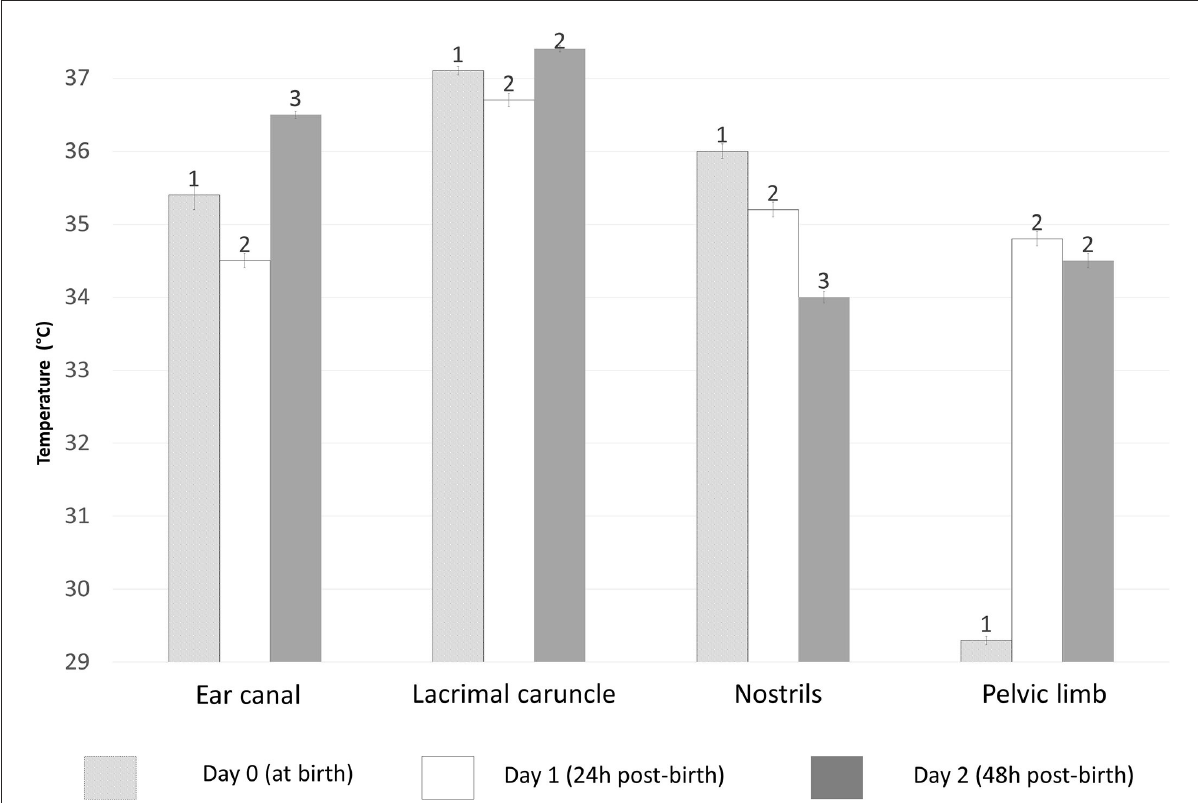
FIGURE6 Effect of age measured in hours (0–48h) on the temperature of newborn buffaloes in different thermal windows. In all events (hours), statistically significant differences ( p < 0.0001) were observed in all measured times, except on the lacrimal gland and pelvic limb windows at 24 and 48h post-birth. The average temperature at the ear canal differed from day 0 to day 2, with the highest value at 48h post-birth (36.5 ◦ C) and the lowest at 24h post-birth (34.5 ◦ C). The lacrimal gland window only showed differences of an average of 0.4 ◦ C from day 0 to day 1. The temperature of the nostril window showed a tendency to drop 0.8 ◦ C from birth to 24h post-birth and 1.2 ◦ C from 24h to 48h post-birth. Meanwhile, a generally lower temperature was observed in the pelvic limb at birth (29.3 ◦ C) but it rose by 5.5 ◦ C at 24h post-birth before decreasing by 0.3 ◦ C at 48h post-birth. Data was obtained using variance analysis (ANOVA) by the mixed general linear model, with multiple comparisons of means using Tukey’s test, Shapiro-Wilk normality test, and a significance level of p < 0.05. 1,2,3 Different numerals indicate significant differences between events according to the age of the buffalo calves ( p <